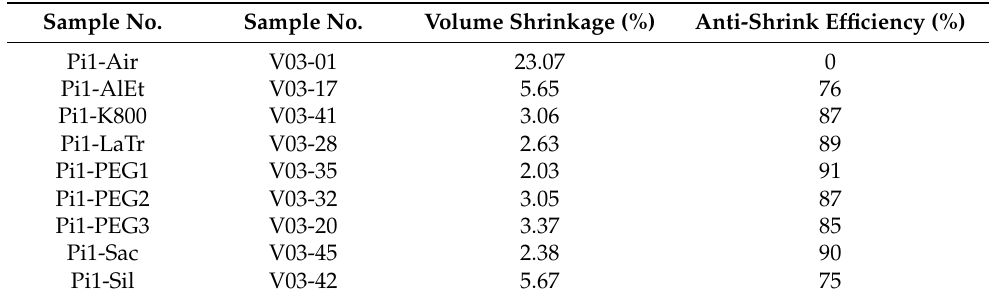
Table 2. Volume stability expressed by the volume shrinkage and anti-shrink efficiency cf. [16,42]. Sample No. Sample No. Volume Shrinkage